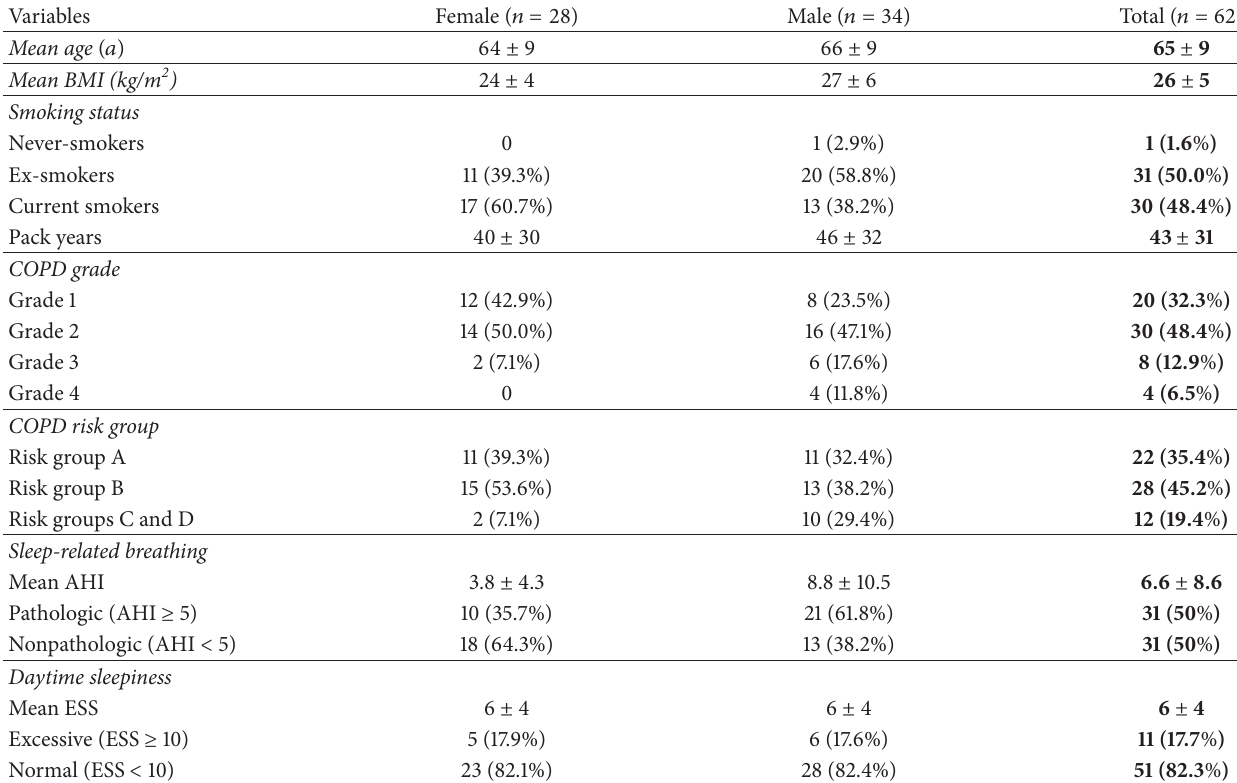
Table 1: Demographic and anthropometric